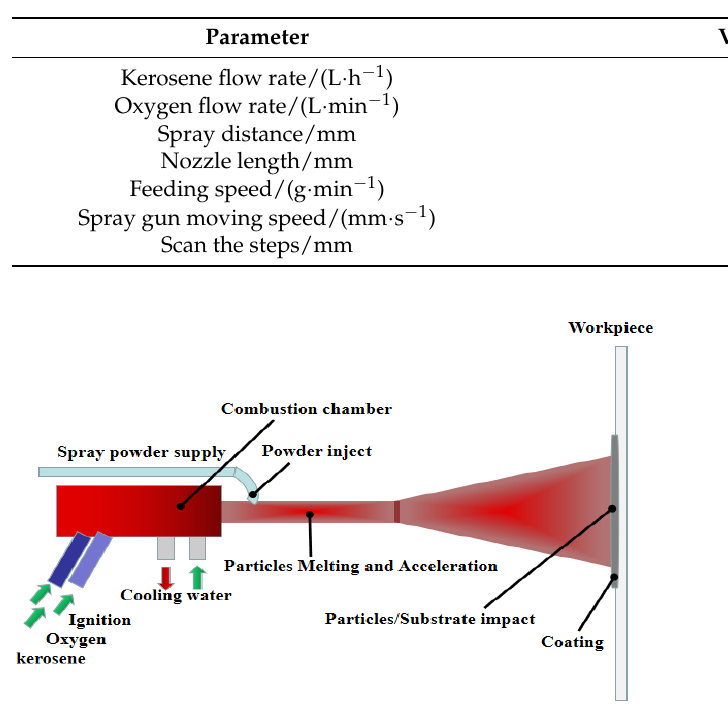
Figure 1. Schematic diagram of HVOF spraying.